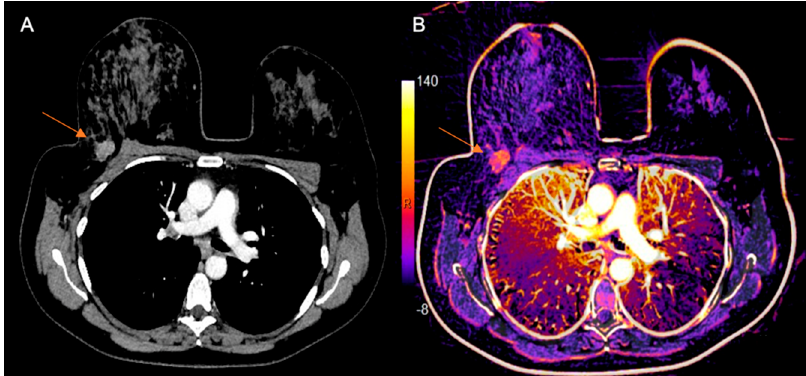
Figure 2. Example of chest MDCT with dedicated breast protocol. ( A ) Post-contrast axial image of chest MDCT in prone position showing a tumor in the right breast (arrow). ( B ) Subtracted imaging with color-coded iodine map showing the same tumor (arrow).